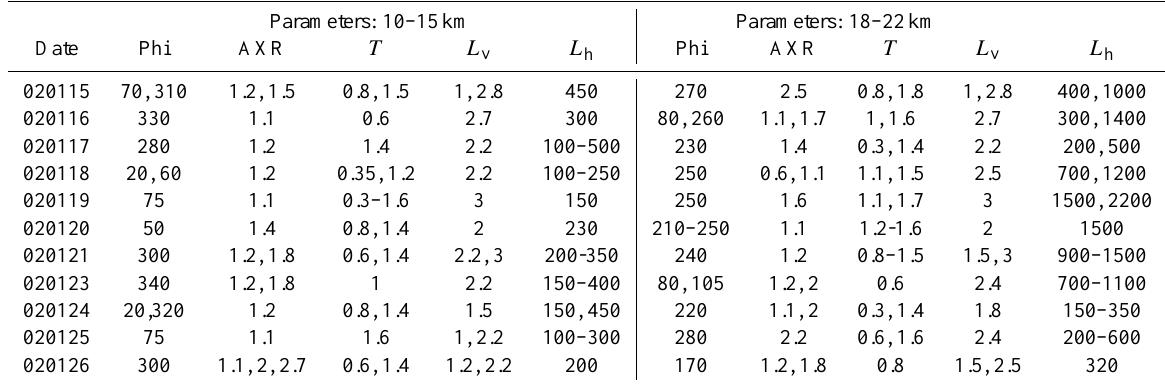
Table 3. GW parameters above Tromelin during 15–26 January 2002 using wavelet analysis (method 5) at 10–15km heights and 18–22km